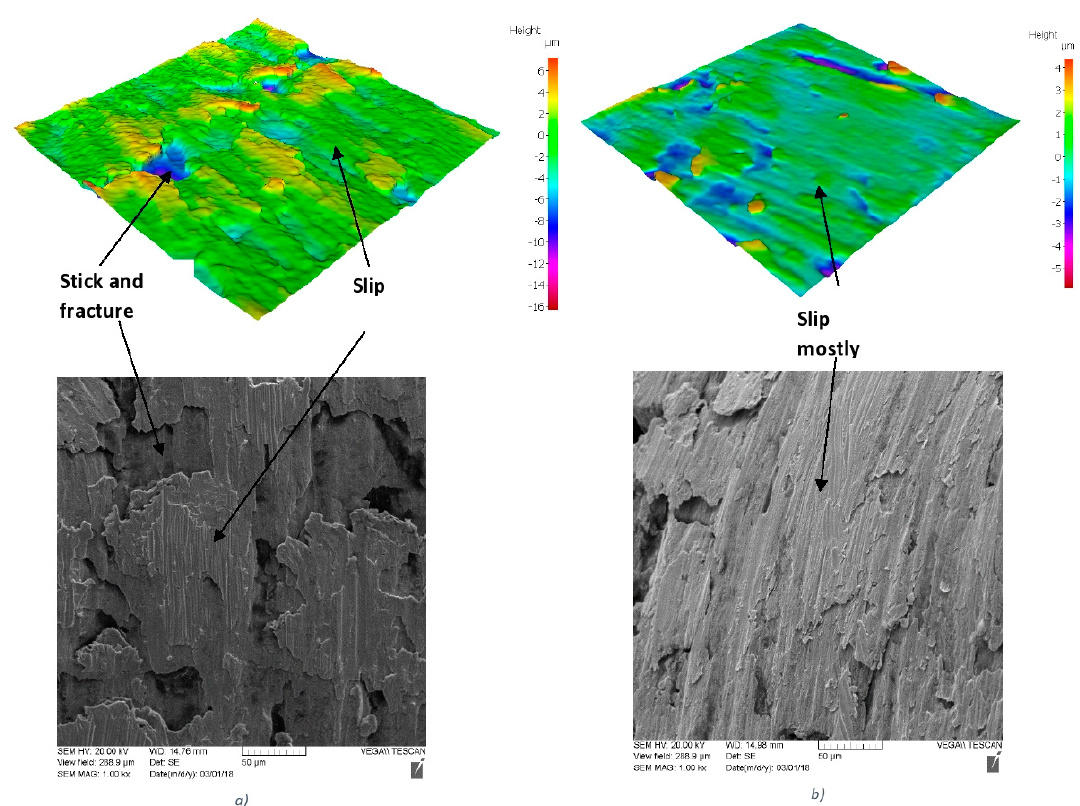
Figure 15. SEM images of chip undersurface combined surface texture obtained by Infinite Focus G5 focus variation microscope (Alicona) with for ( a ) regular PVD arc (benchmark) coating and ( b ) low-stress TiAlN multilayer coating.